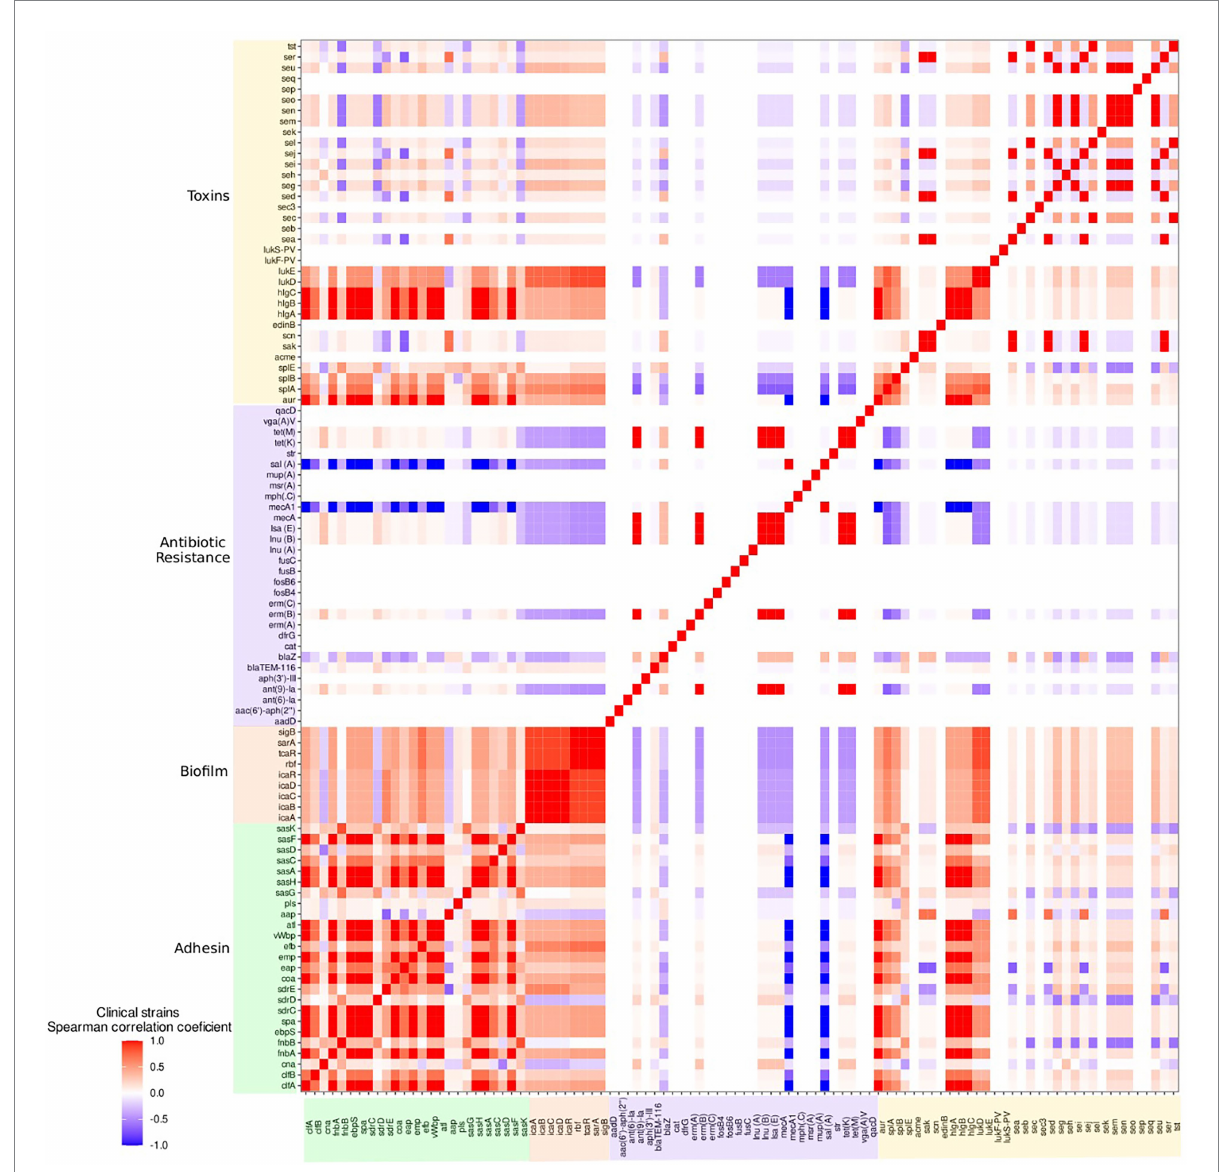
FIGURE 6 Heat map of the correlation, by the Spearman test, of the presence of S. aureus adhesion, biofilm, toxin, and antimicrobial resistance genes in clinical mastitis